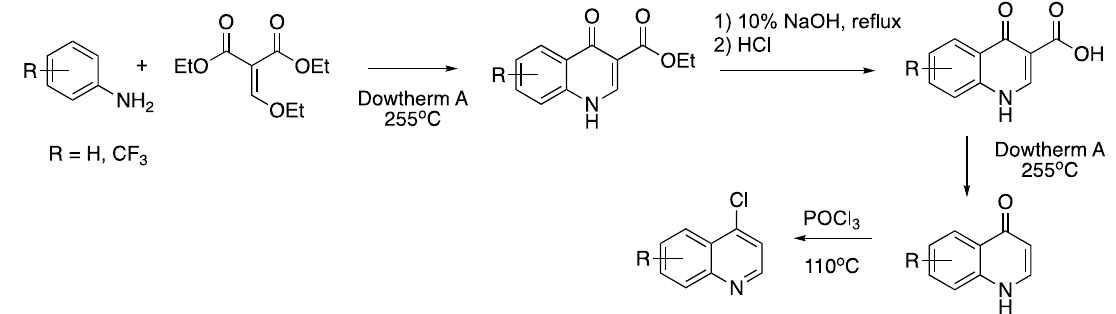
Figure 2. Synthesis of 4-chloroquinolines by the Gould–Jacobs reaction, followed by chlorination with phosphorus oxychloride.